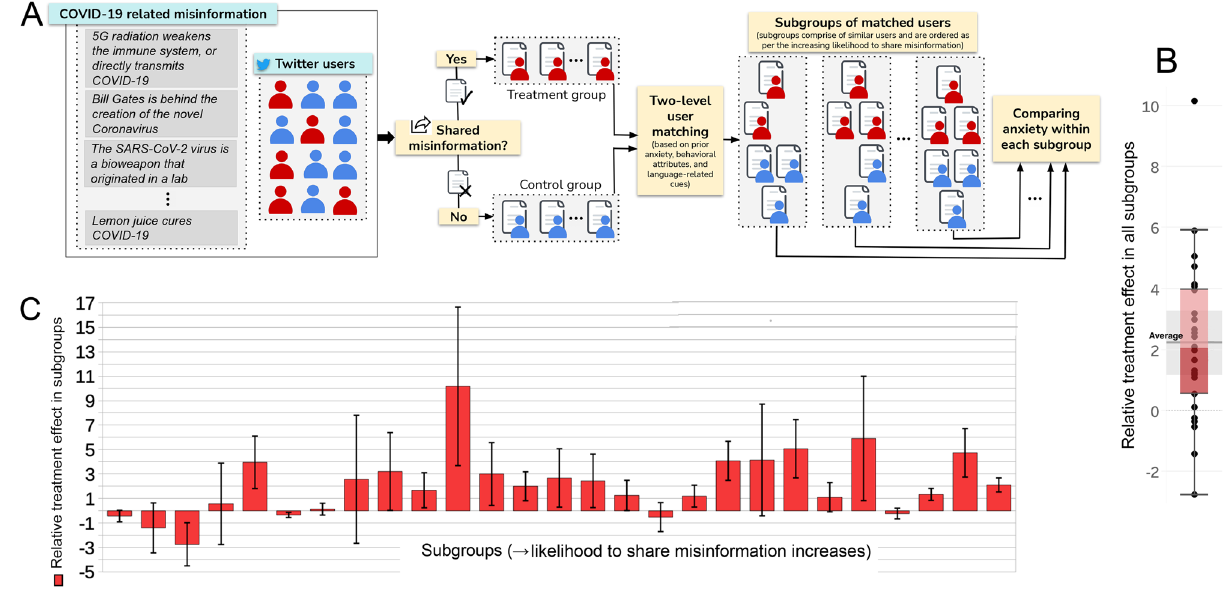
Figure 1. Causal inference methodology ( A ) and the effect of sharing misinformation on experiencing anxiety—overall distribution ( B ) and subgroup-wise values ( C ). We illustrate our methodology to study the causal effect of sharing misinformation (treatment) on experiencing heightened anxiety (outcome) ( A ). We identify users who shared considerable COVID-19 misinformation on Twitter and assign them to the treatment group, while assigning the ones who did not share any misinformation to the control group. We then employ a two-level matching strategy to identify similar users across the two groups, using several factors like prior anxiety, other prior mental health indicators, platform-specific behavioral attributes, and language-related cues. Within each subgroup of matched users, we compare the aggregate anxiety levels of treatment and control users using their post-treatment Twitter posts to estimate the effect of sharing misinformation. In B , we show a box and whisker plot of relative treatment effect across all subgroups. The average, first and third quartiles, and the 95% confidence interval all lie above 0. The relative treatment effect in each subgroup and the 95% confidence interval are shown in C . Values that are > 0 indicate a positive effect of sharing misinformation on anxiety within that subgroup. The subgroups are ordered as per the increasing likelihood of sharing misinformation (propensity scores). Regardless of the likelihood to share misinformation, in most subgroups, users who shared misinformation experienced exacerbated anxiety when compared to similar users who did not share